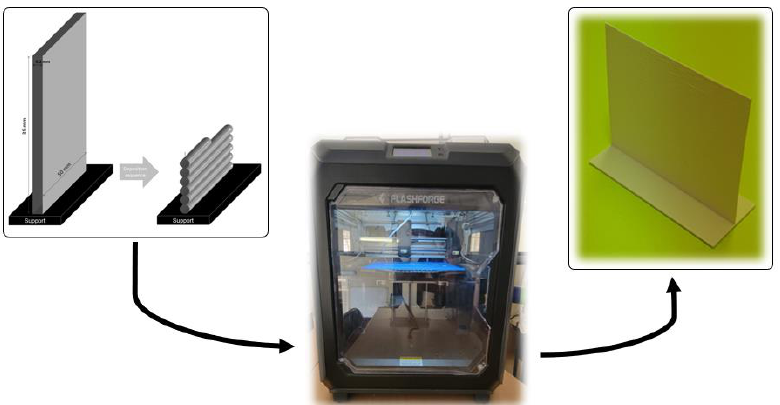
Figure 1. Representation of the solid bock (vertical wall), applied FFF machine, and the printed solid block.